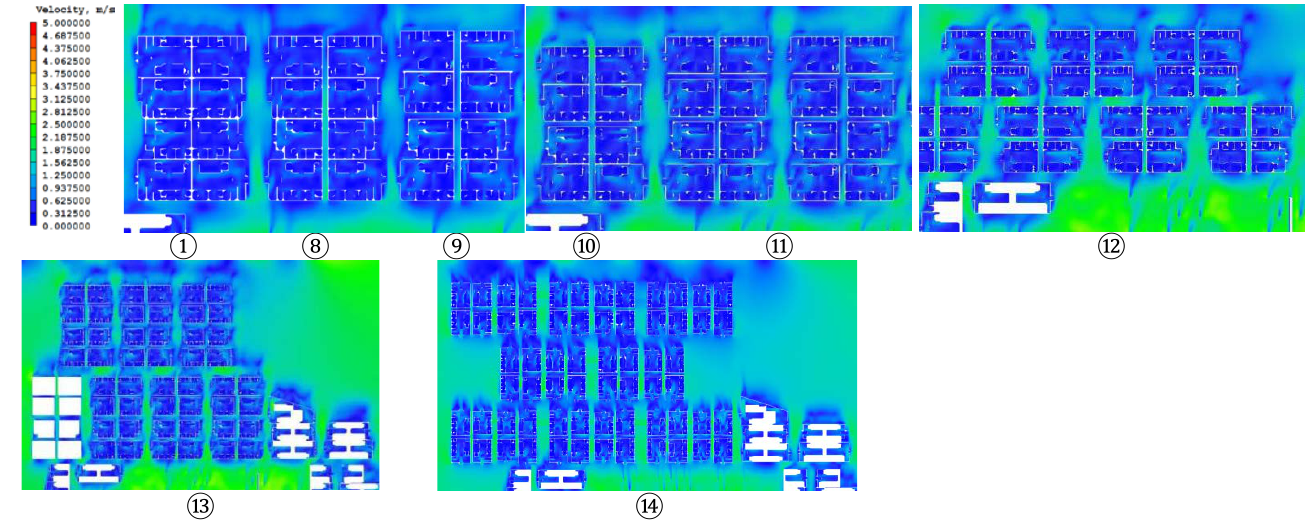
⑭ Figure 10. Simulation results of planar grouping optimization